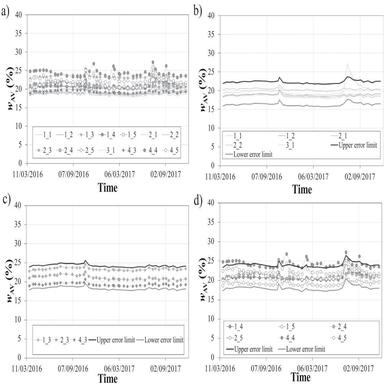
(a) Evolution of wAV in the PG1 profiles. (b) Evolution in the PG1S subgroup. (c) PG1C subgroup. (d) PG1N subgroup.